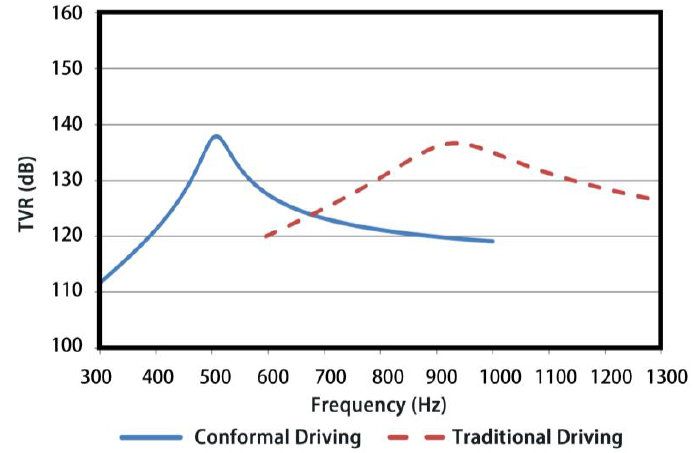
Figure 16. TVRs of the conformal and conventional driving Class IV FT.